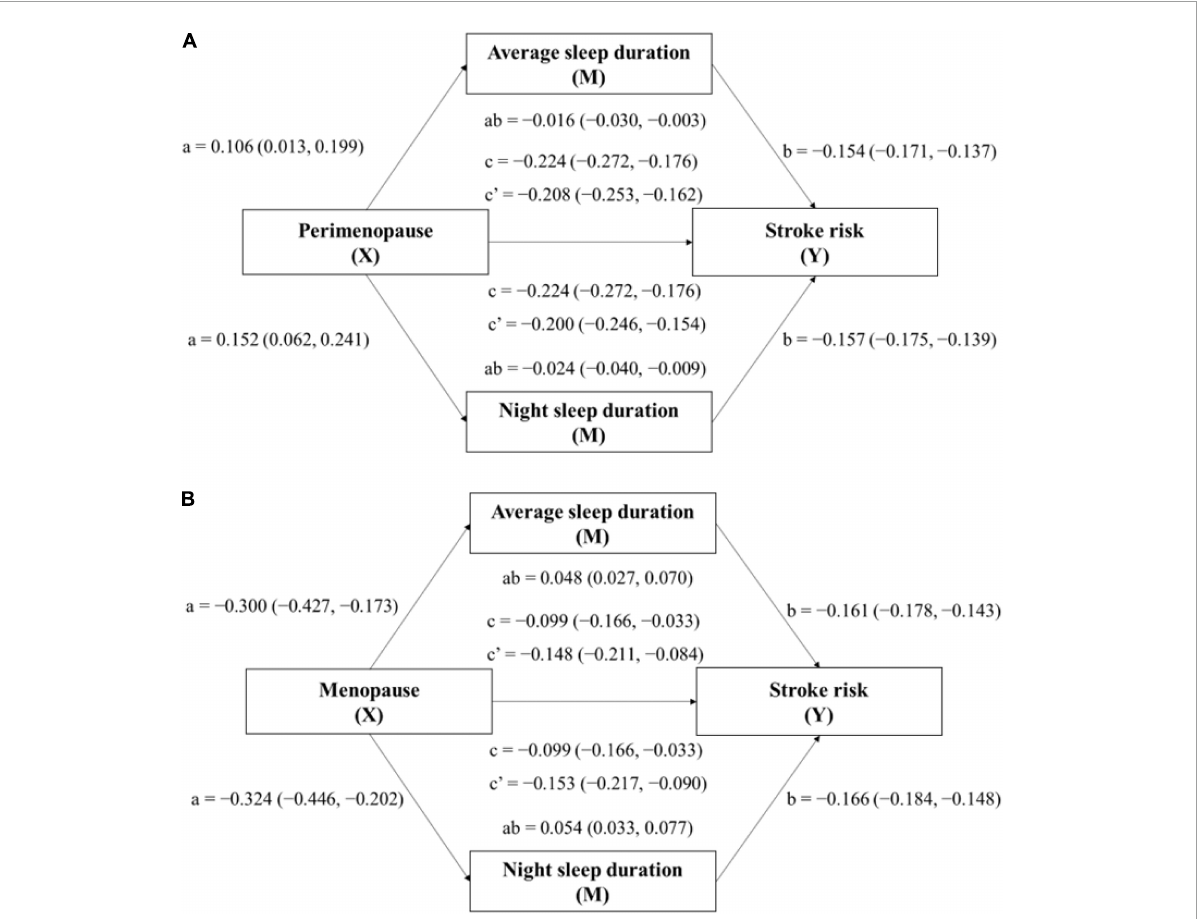
FIGURE3 Mediation model for the relationship between menopausal status (Perimenopause: model A ; Menopause: model B ) and stroke risk, mediated by average sleep duration and night sleep duration. Paths a, b, c, and c (cid:48) are presented as unstandardized coefficients (95% CI). a = X on M; b = M on Y; c = total effect of X on Y; c (cid:48) = direct effect of X on Y; ab = indirect effect of X on Y. Covariates: age, education, marital status, and